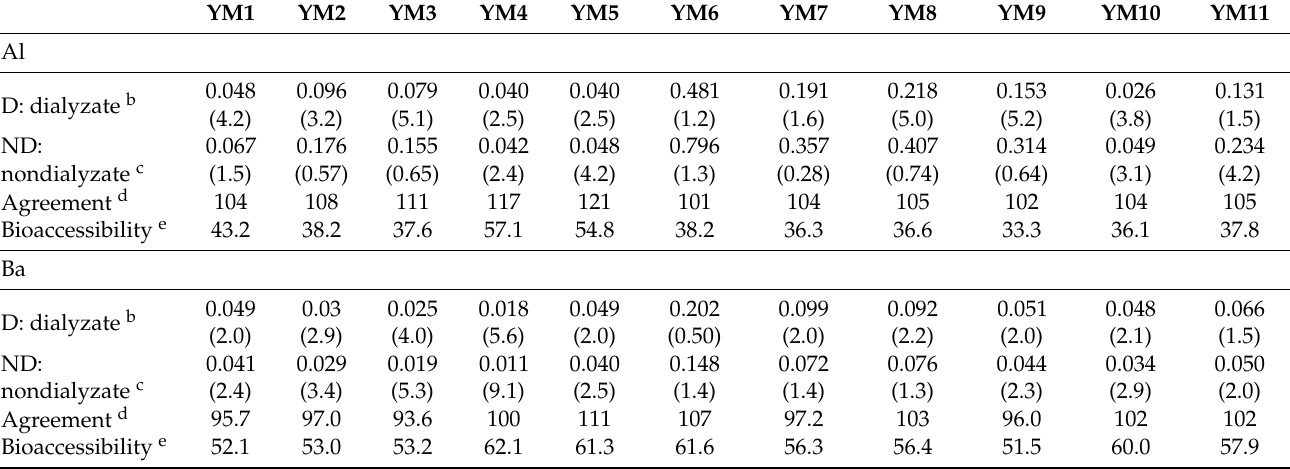
Table 4. Concentrations a of elements and caffeine determined by ICP-OES and UV–VIS spectropho- tometry, respectively, in the dialyzable and nondialyzable fractions of the analyzed yerba mate (YM) energy drinks